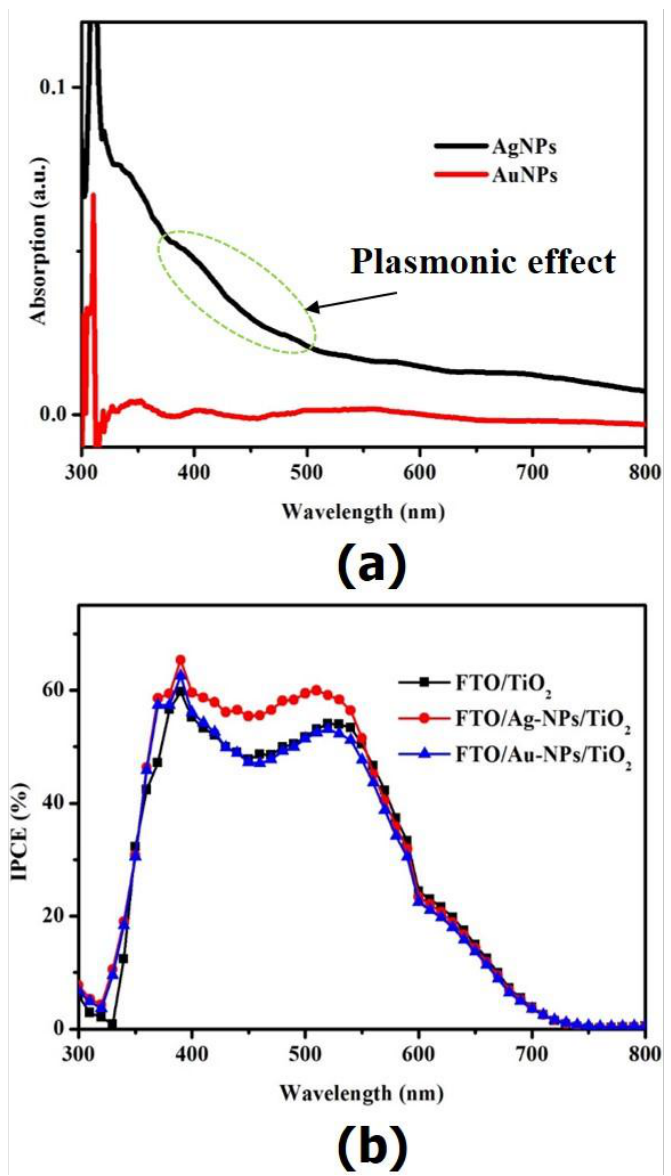
Figure 4. ( a ) Absorption spectra of AuNPs and AgNPs; ( b ) Incident photon-to-current efficiency (IPCE) spectra of DSCs based on different working electrodes. a.u.: arbitrary unit.